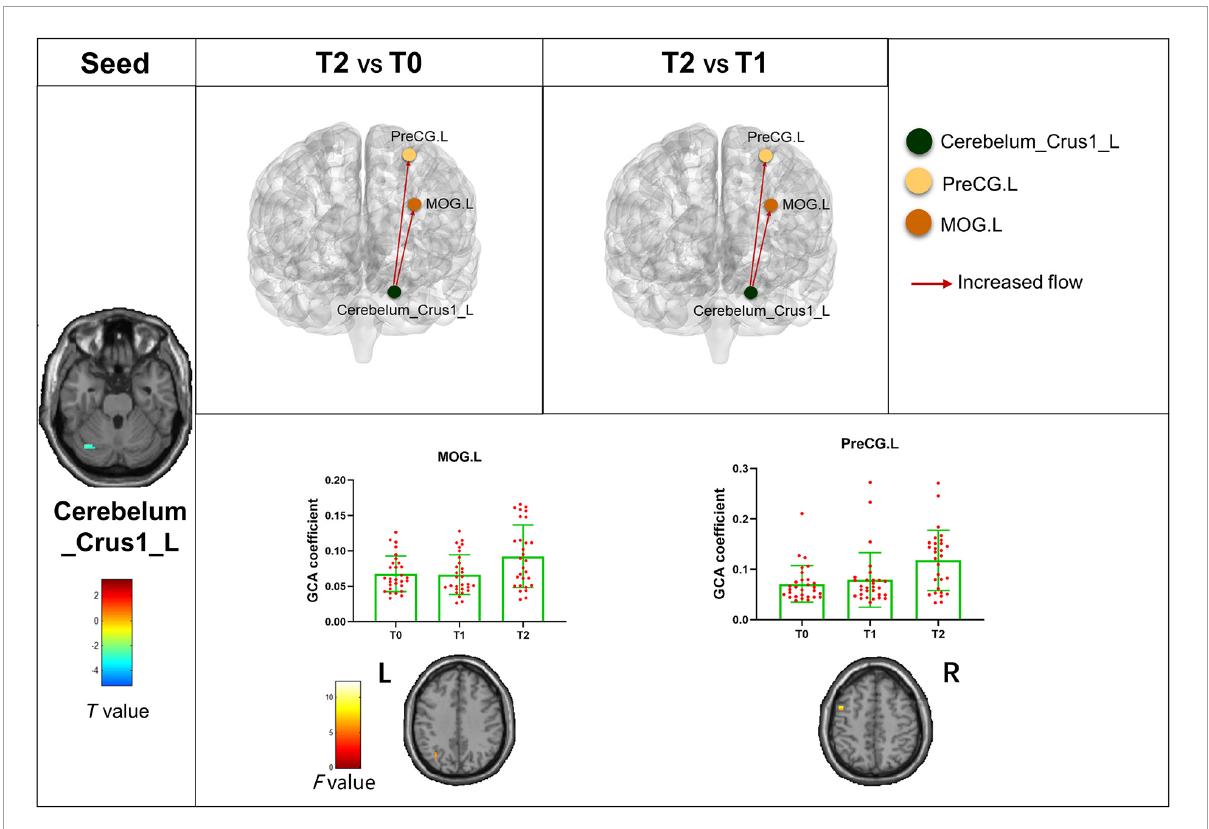
FIGURE5 Abnormal effective connectivity pathways associated with the Cerebellum_Crus1_L. Each bar chart reflects the values of the dynamic GCA coefficient in the corresponding group. Fuchsia arrows indicate significantly enhanced DEC variability. T0, the time point at baseline; T1, the time point after the first acupuncture session; T2, the time point after the 12th acupuncture sessions. All abbreviations are defined in the Abbreviations